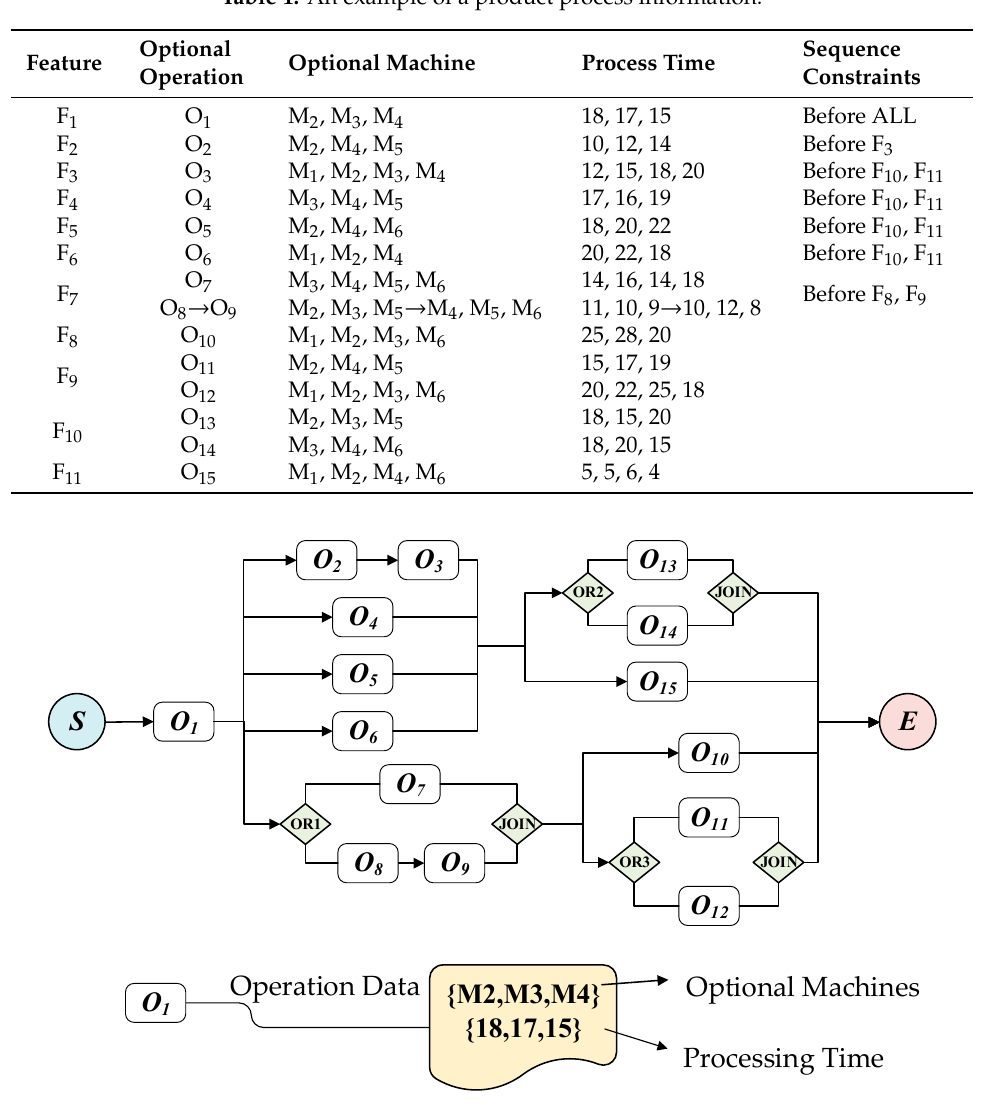
Figure 1. An example of a product AND/OR network figure.